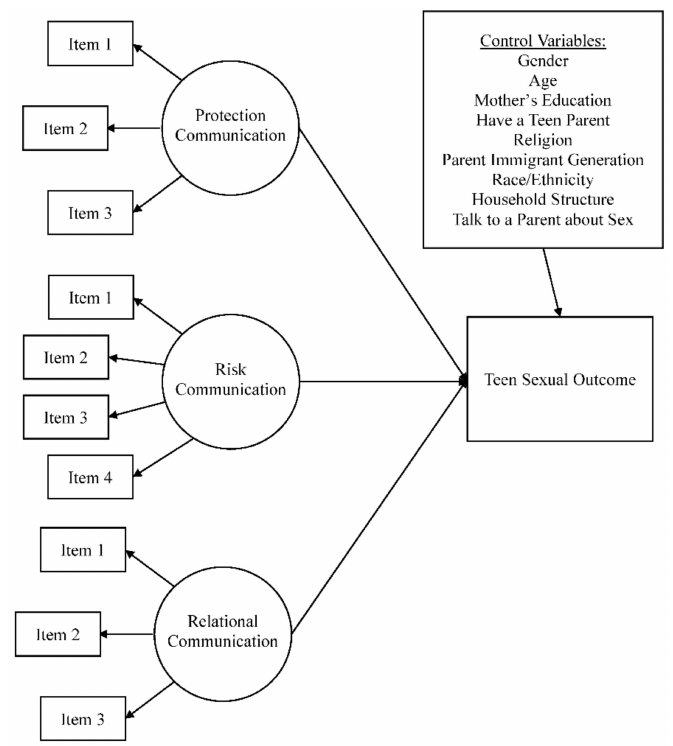
Figure 1. Structural equation measurement model of communication and sexual